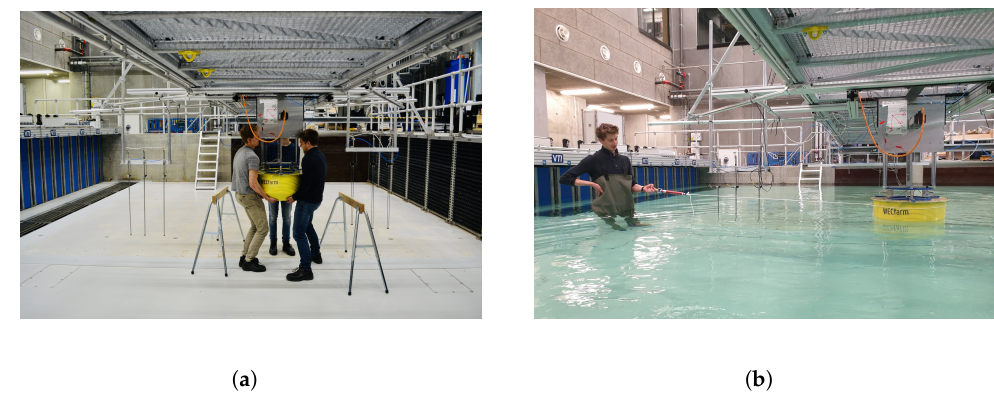
Figure 6. Friction characterization tests ( a ) in the empty AAU wave basin; ( b ) with application of lateral loading in